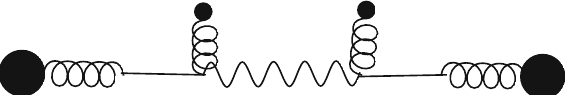
Fig. 5 The diagram for the confining interaction